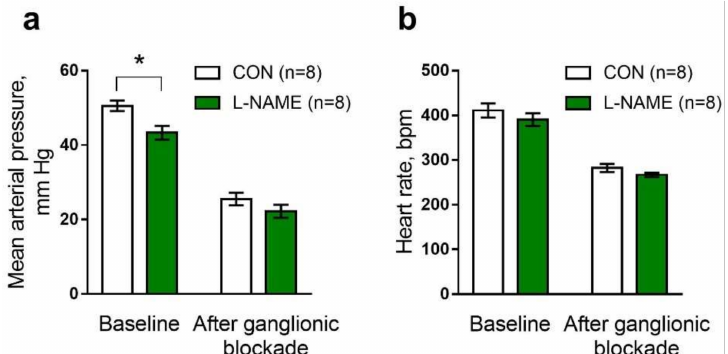
Figure 6. Systemic cardiovascular parameters of anesthetized two-week-old offspring before and after the ganglionic blockade. Mean arterial pressure ( a ) and heart rate ( b ) values before (baseline) and after ganglionic blockade (chlorisondamine, 2.5 mg/kg) in pups from control (CON) and L- NAME groups. Data are presented as the mean ± S.E.M., n , number of animals. * p < 0.05 (unpaired Student’s t